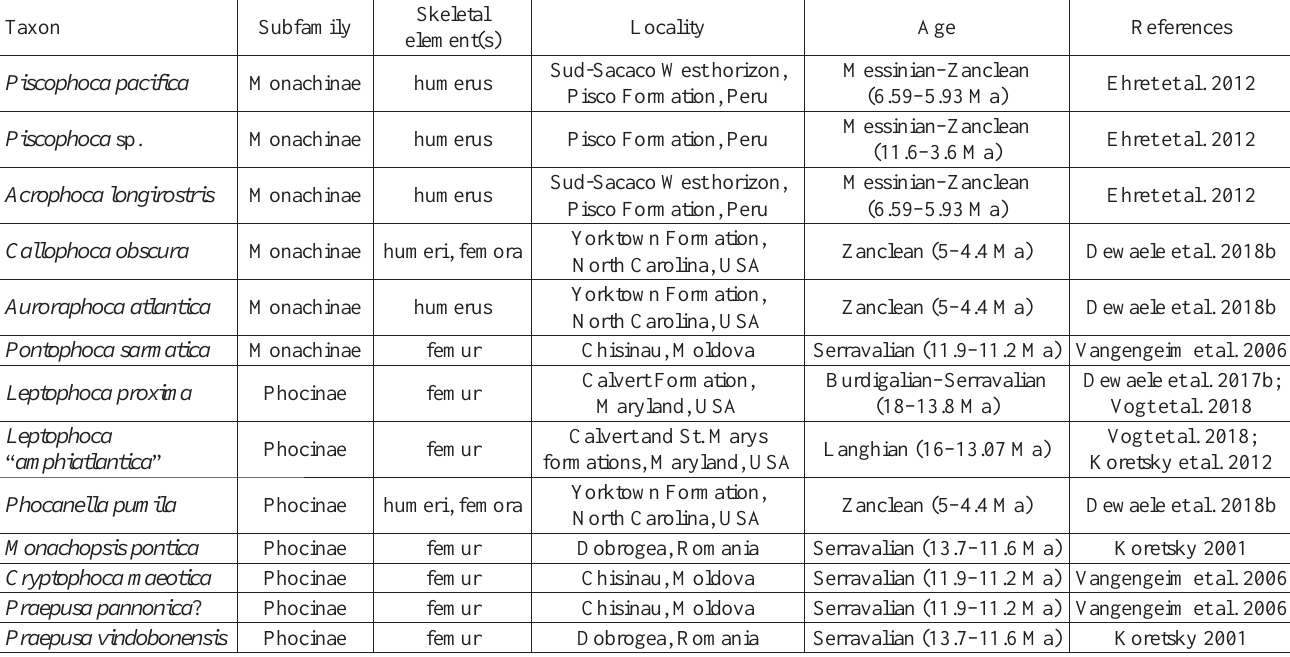
Table 1. Fossil taxa, with age and locality information, included in this